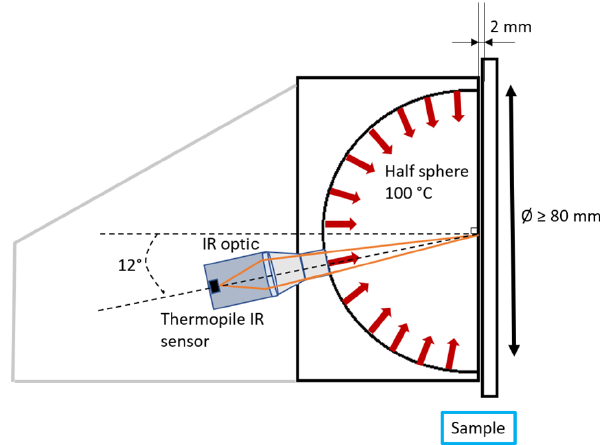
Figure 1. Working principle of the TIR 100-2 (side view) for direc- tional total emissivity measurement.